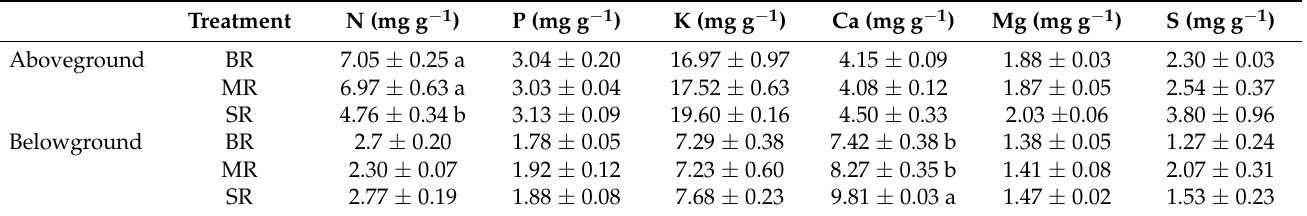
Table 5. The nutrient concentrations in aboveground and belowground parts of plantlets at the end of EXP.1 (32 DAP).